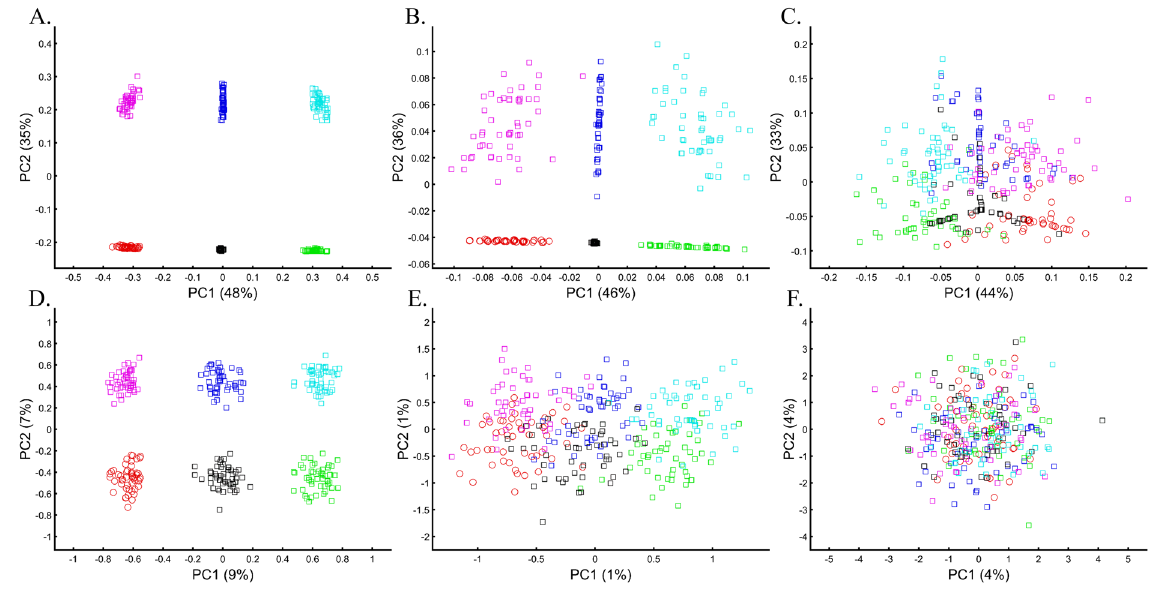
Figure 21. Testing the effects of missingness and noise in a PCA of six fixed-size ( n = 50) samples from color populations. The top plots show the effect of missingness alone or combined with noise: ( A ) 50% missingness, ( B ) 90% missingness, and ( C ) 90% missingness and low-level random noise in all the markers. The bottom plots test the effect of noise when added to the original markers in the above plots using: ( D ) 30 random markers, ( E ) 300 random markers, and ( F ) 3000 random markers. Colors include Red [1,0,0], Green [0,1,0], Blue [0,0,1], Cyan [0,1,1], Yellow [1,1,0], and Black